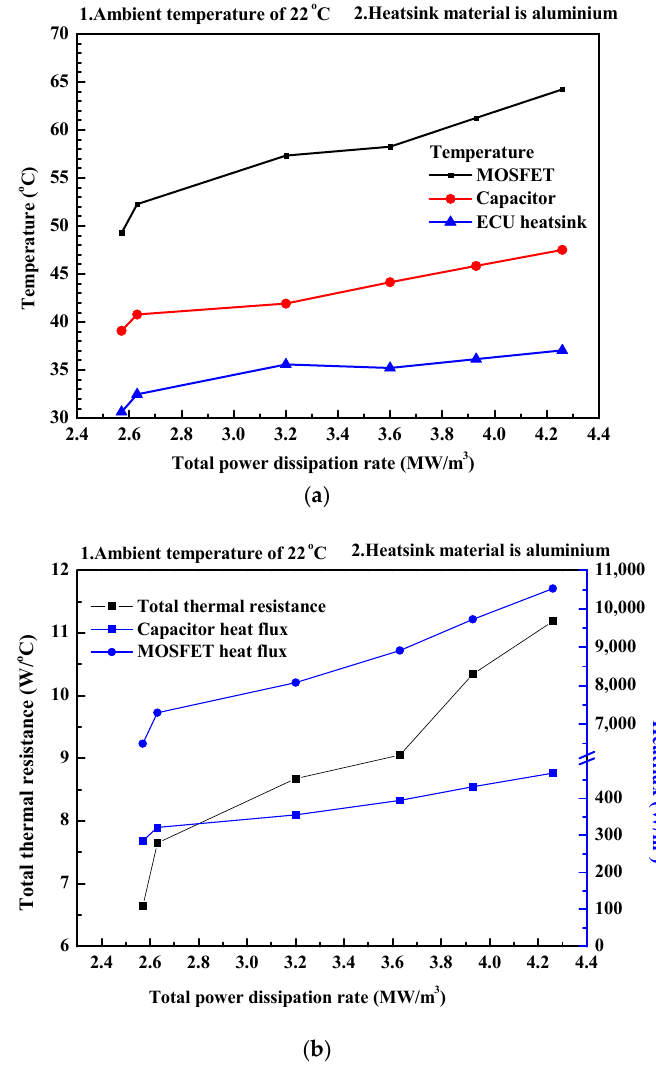
Figure 10. Temperature, total thermal resistance and heat flux of the 36V ECU heatsink with the total power dissipation rate: ( a ) Maximum temperature variation with the total power dissipation; ( b ) Total thermal resistance and heat flux variation with the total power dissipation.